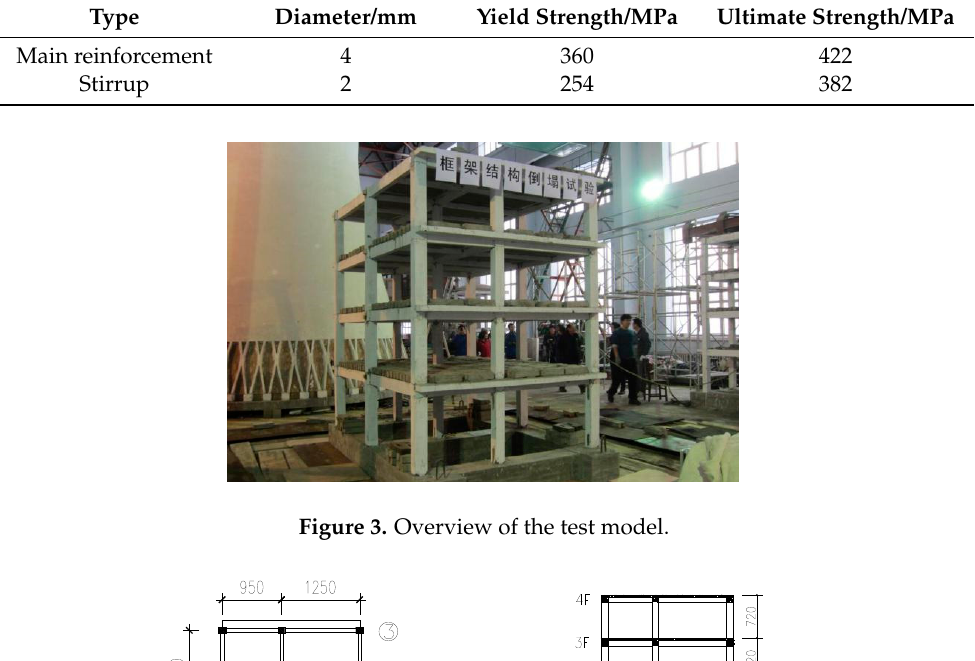
Table 2. Mechanical properties of reinforcement.